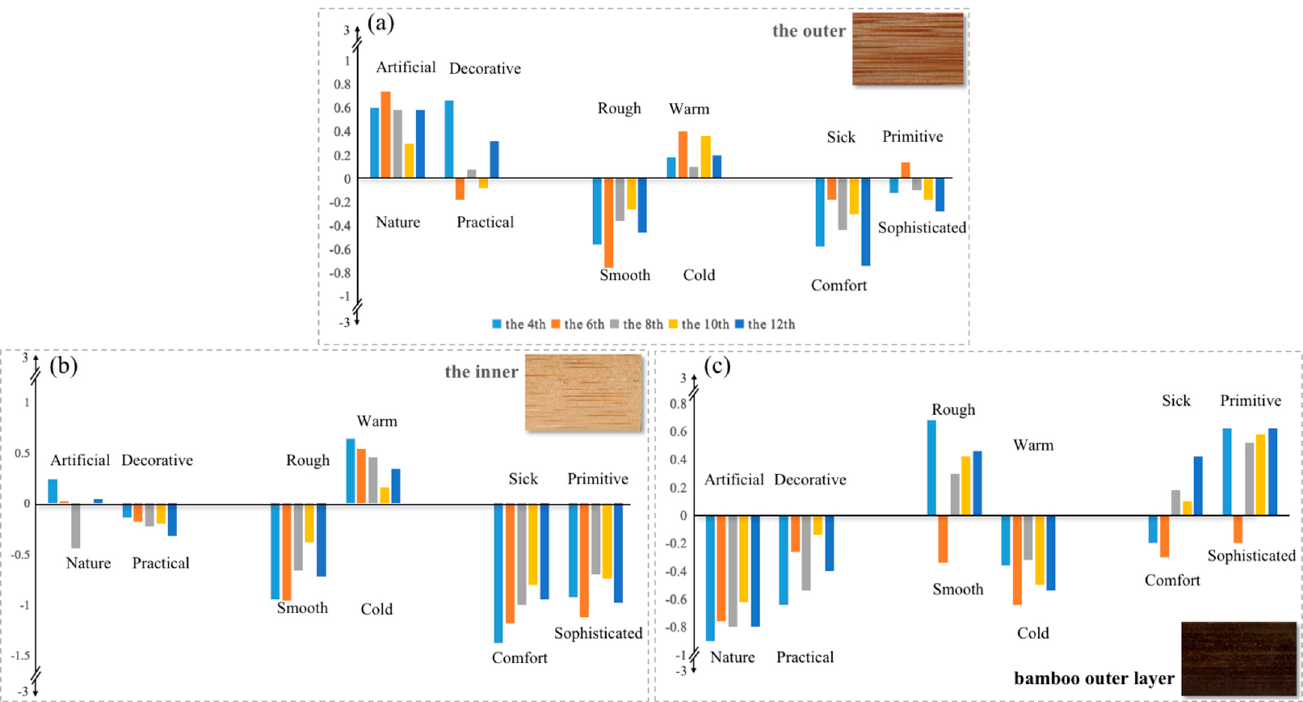
Figure 4. Distribution of visual psychological quantities in different parts of the bamboo culm. ( a ) The distribution in the outer surface. ( b ) The distribution in the inner surface. ( c ) The distribution in the bamboo outer layer surface.